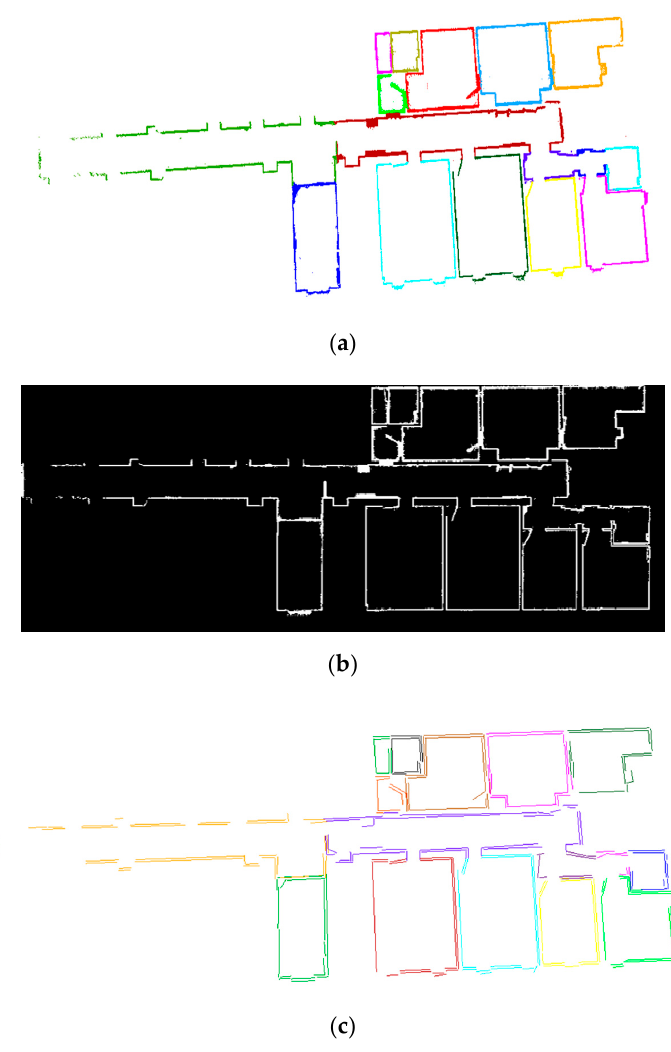
Figure 7. Floorplan Line extraction. ( a ) Split labeled point clouds from given height. ( b ) The conversion of projected points into a binary image. ( c ) Extraction of line elements with label information.